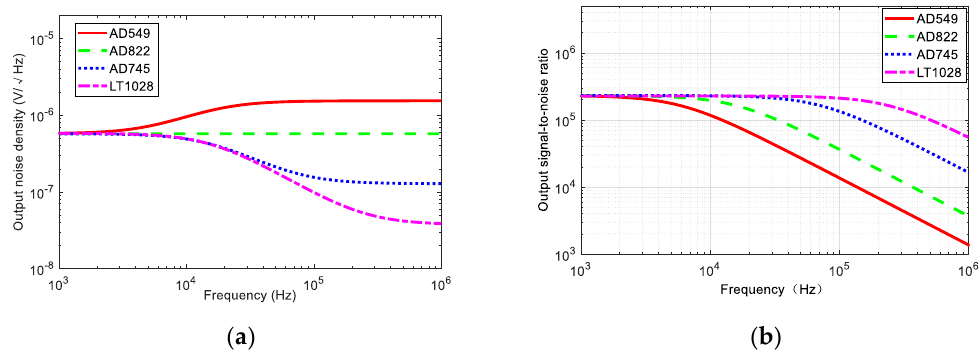
Figure 5. Model results. ( a ) The output noise voltage density E no of different amplifiers. ( b ) The output signal-to-noise ratio R sn of different amplifiers.